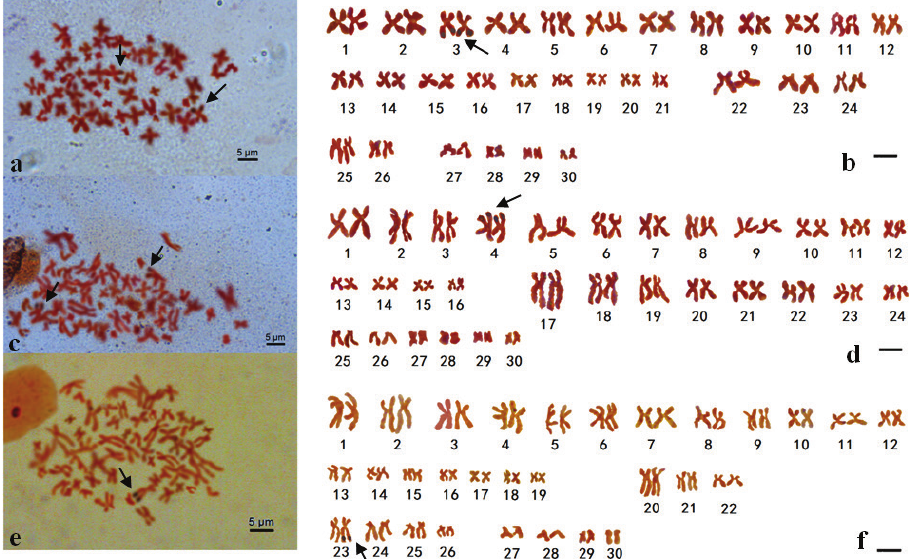
Figure 2. Karyotypes and NOR-bearing chromosomes from three species of octopod gills. a The metaphase plate of O. minor b Karyogram of O. minor from ( a ) showed that Ag-NOR loci were located on the long arms of metacentric chromosome 3 c The metaphase plate of A. fangsiao d Karyogram of A. fangsiao from ( c ) showed that Ag-NOR loci were located on the short arms of metacentric chromosome 4 e The metaphase plate of C. chinensis f Karyogram of C. chinensis from ( e ) showed that Ag-NOR loci were located on long arms of subtelomeric chromosome 23. Arrows indicate the NOR-bearing chromosomes. Scale bars: 5